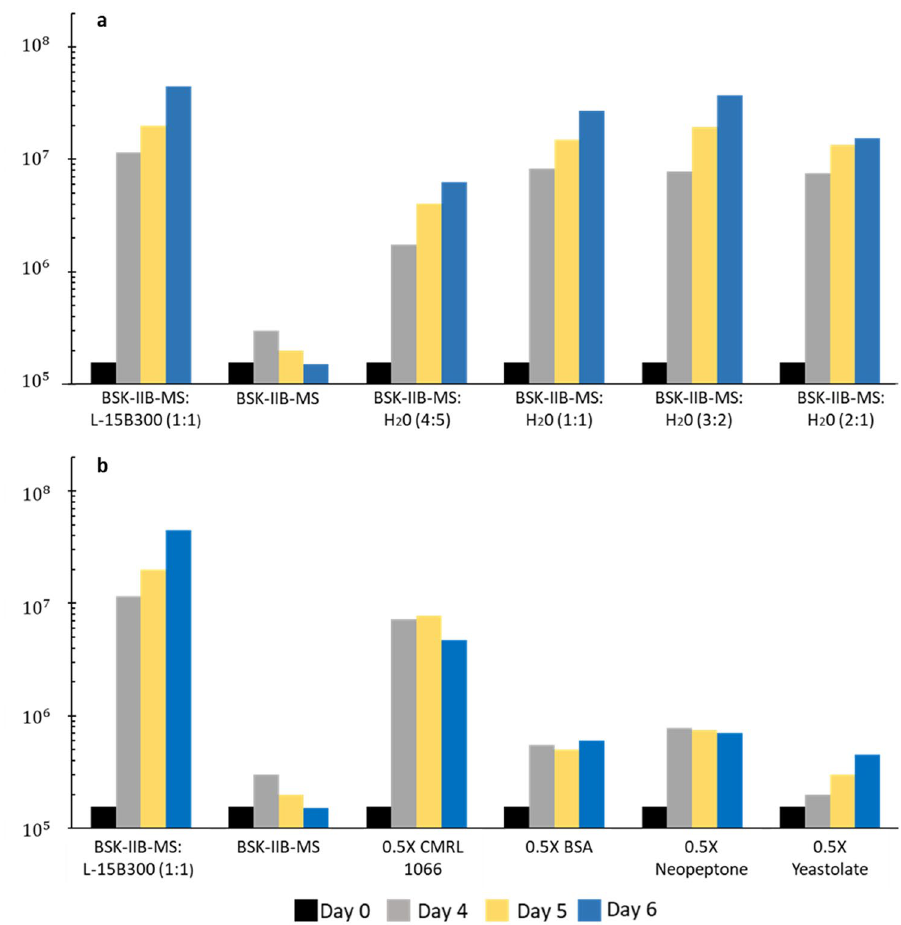
Figure 2. Inhibition of B. miyamotoi growth in BSK-IIB-MS. ( a ) Side-by-side comparisons of observed cell densities (spirochetes/mL) upon inoculation of BSK-IIB-MS:L-15B300 (1:1), BSK-IIB-MS alone and BSK-IIB-MS diluted with H 2 0 at the indicated ratios. Actively growing spirochetes were seeded into media formulations at a final concentration of 1. 6 × 10 5 spirochetes/mL. The percentages of BSK-IIB-MS to H 2 0 in the 1:1 and 3:2 ratios, was 50:50 and 60:40, respectively. ( b ) Side by side comparisons of cell densities in BSK-IIB:L- 15B300 (1:1), BSK-IIB-MS alone, and BSK-IIB-MS with individual indicated components reduced by half. The final concentration of indicated components was 4.04 g/L CMRL 1066 10X w/o L-glutamine, 20.85 g/L BSA, 2.01 g/L Bacto neopeptone and 0.84 g/L Bacto TC yeastolate. Actively growing spirochetes were seeded into media formulations at a final concentration of 1. 6 × 10 5 spirochetes/mL. ( a , b ) Spirochete densities by day are indicated by color: day 0, black; day 4, grey; day 5, yellow; day 6,